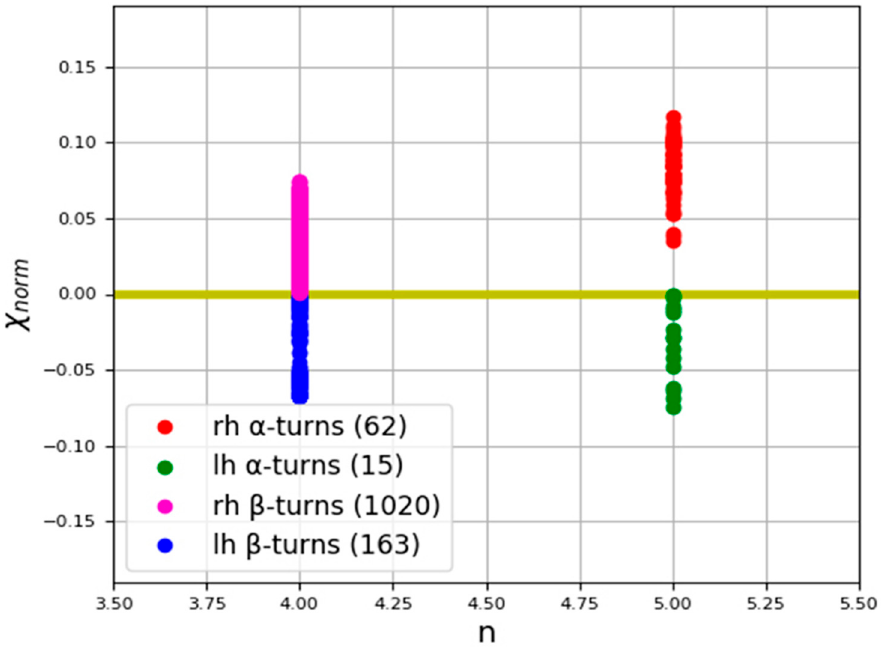
Figure 11. Normalized chirality map of α - and β -turns (mean values of various types presented in Tables 1 and 2). The horizontal axis is the length of the secondary structure in amino acid residues, the vertical axis is the normalized chirality value; rh–right-handed structures, lh–left-handed structures.